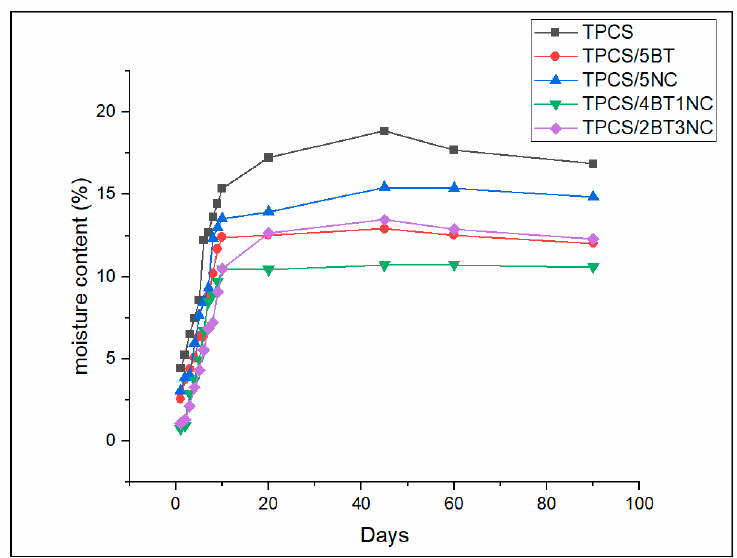
Figure 6. Moisture absorption percentage for virgin TPCS, TPCS-C, and TPCS-HC films aged for 90